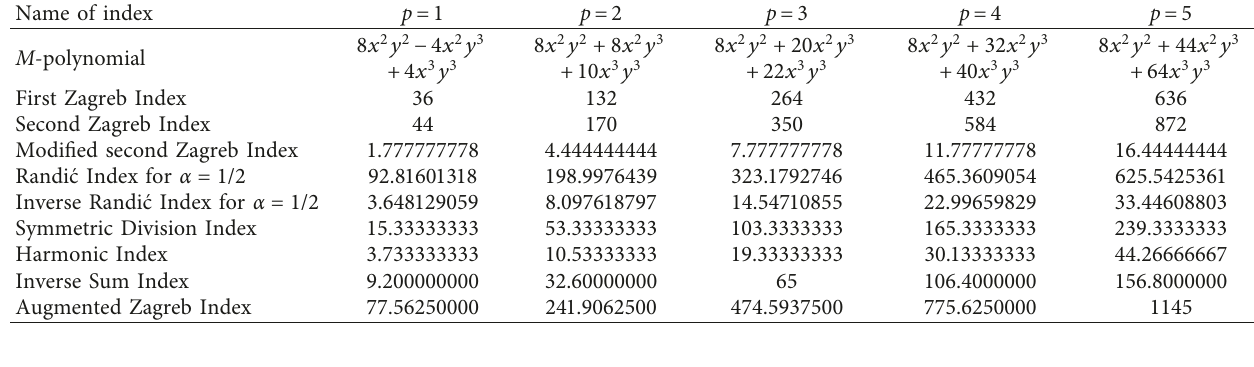
Table 2: Topological indices of benzenoid hourglass for different values of p .